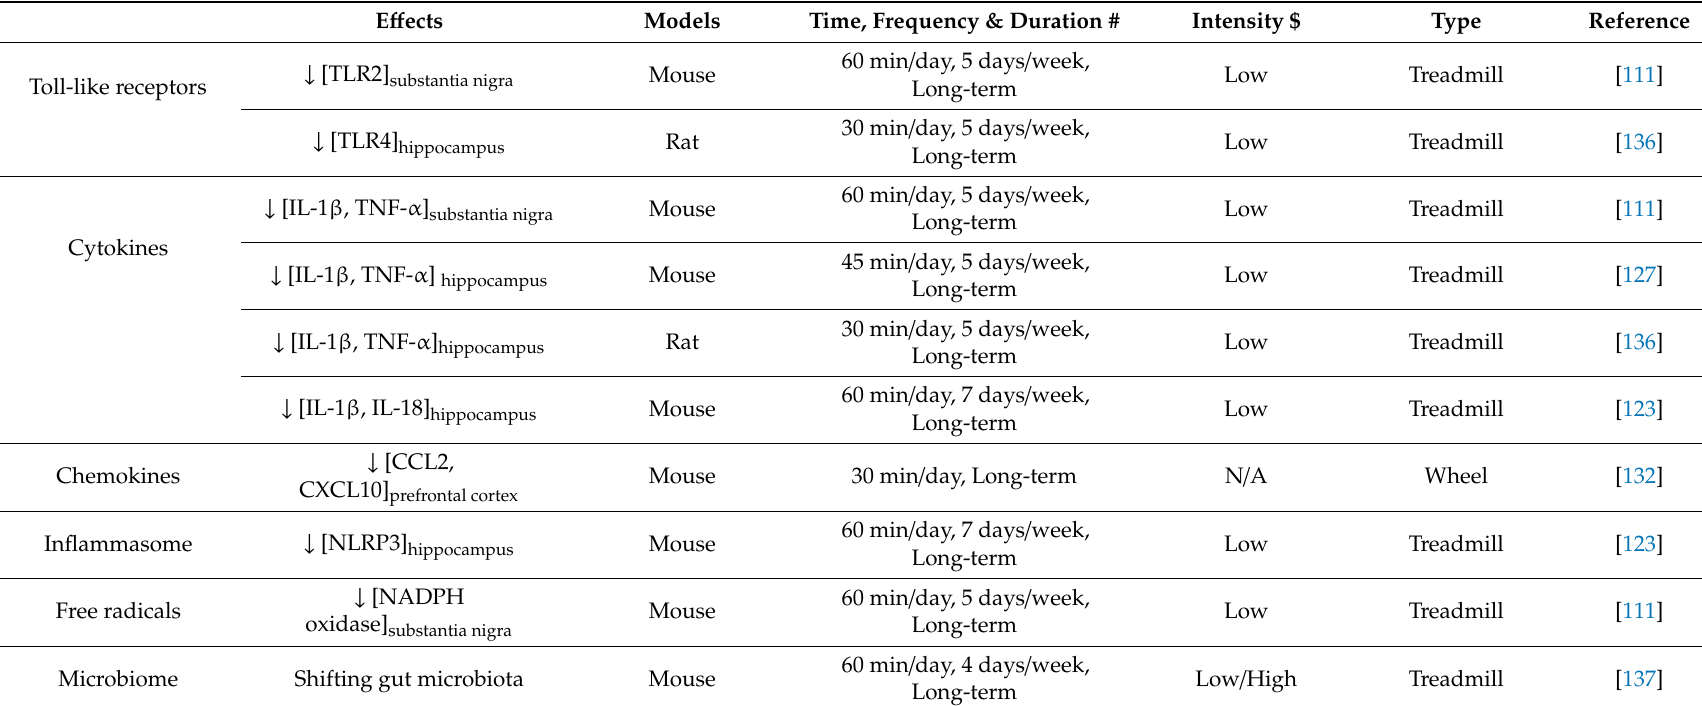
Table 2. Exercise regulates microglial activation by decreasing pro-inflammatory